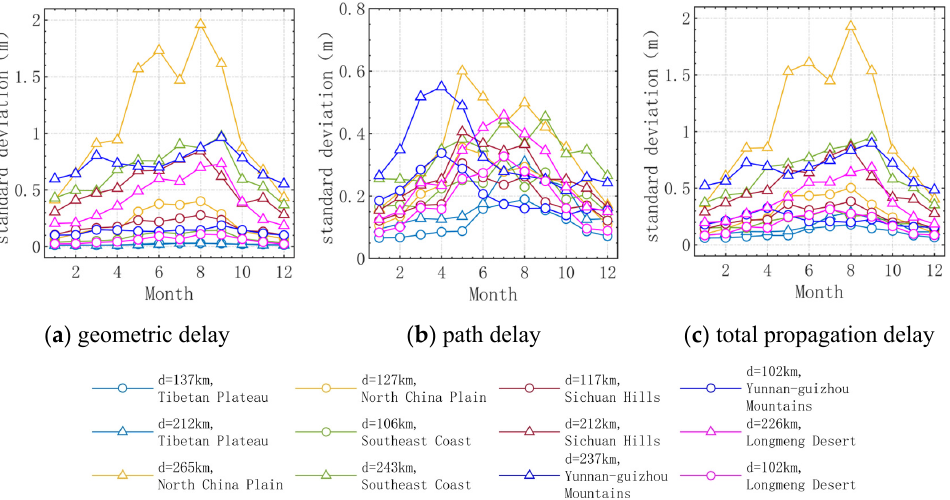
Figure 8. Hourly fluctuation standard deviation of geometric delay, path delay, and total propagation Figure 8. Hourly fl uctuation standard deviation of geometric delay, path delay, and total delay: ( a ) hourly fluctuation standard deviation of geometric delay, ( b ) hourly fluctuation standard propagation delay: ( a ) hourly fl uctuation standard deviation of geometric delay, ( b ) hourly fl uctuation standard deviation of path delay, ( c ) hourly fl uctuation standard deviation of total deviation of path delay, ( c ) hourly fluctuation standard deviation of total propagation propagation delay.